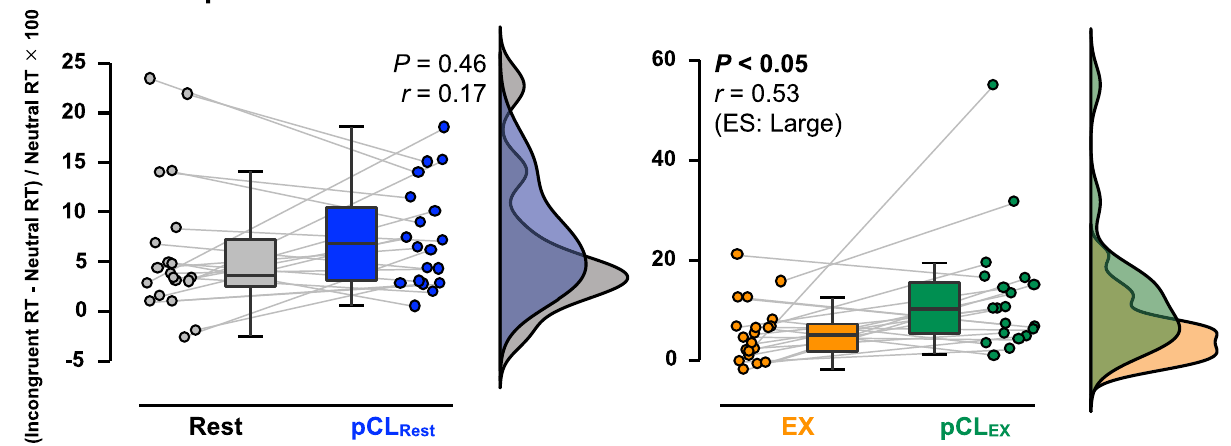
Figure 5. The reverse-Stroop interference score during the last 5 min of interventions. Raincloud plots showing the distribution of reverse-Stroop interference score. Circle plots represent individual data, and box-and- whisker plots are median (IQR and max/min).